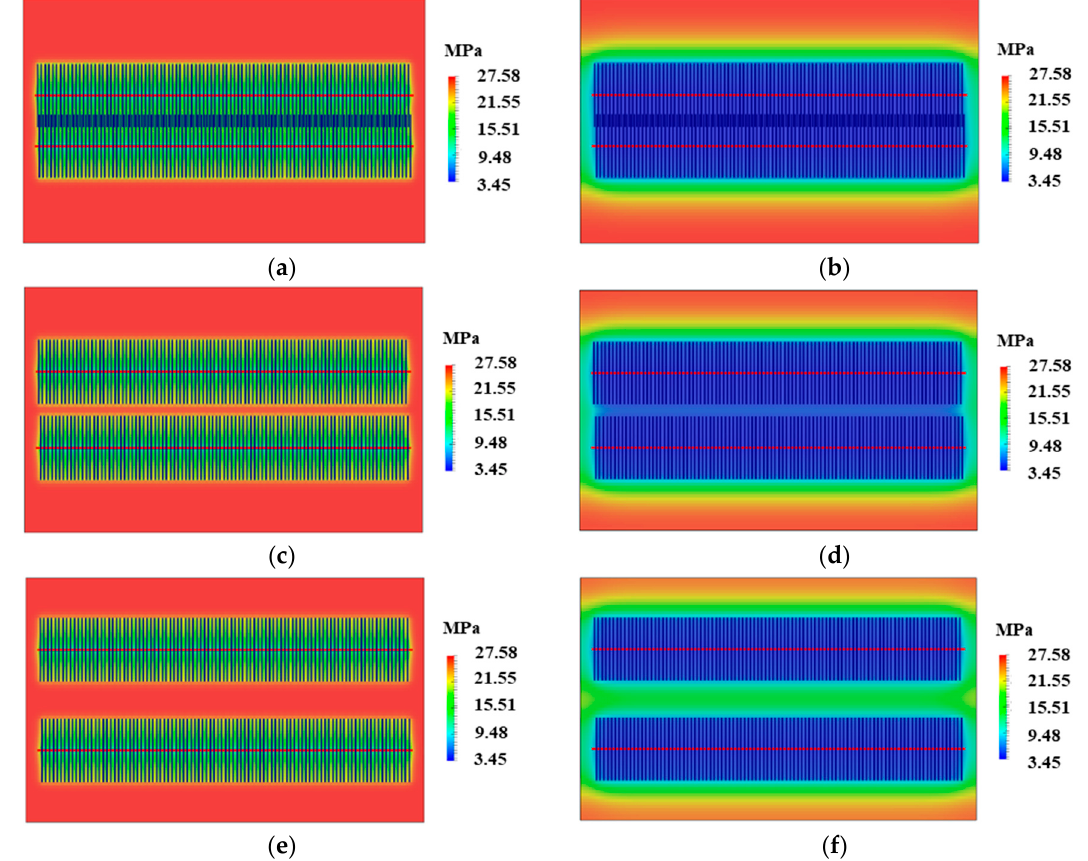
Figure 12. Comparison of pressure distribution after 1 and 30 years of production under different well spacing without natural fractures: ( a ) After 1 year of production with well spacing 200 m; ( b ) After 30 years of production with well spacing 200 m; ( c ) After 1 year of production with well spacing 300 m; ( d ) After 30 years of production with well spacing 300 m; ( e ) After 1 year of production with well spacing 400 m; ( f ) After 30 years of production with well spacing 400 m.